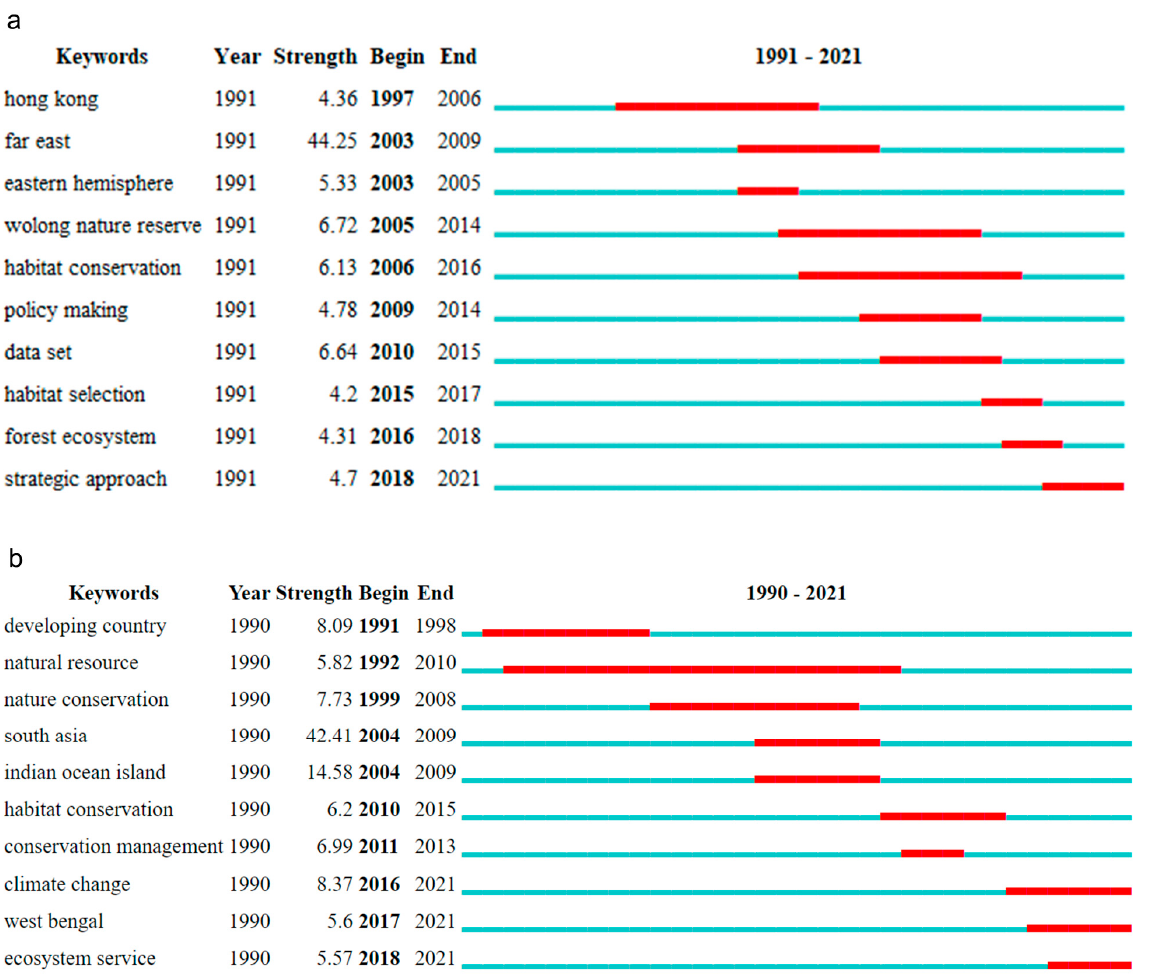
Figure 7. Top 10 keywords with the strongest citation bursts in CPAP ( a ) and IPAP ( b ) from 1990 to 2021.